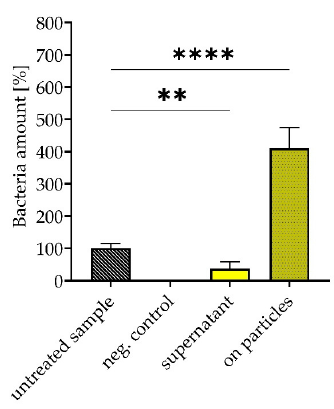
Figure 9. Removal and enrichment of S. aureus from platelet concentrate using 300 µg Fe/mL SPION- APTES-PepA. Samples were spiked with bacteria at a concentration of 10 3 CFU/mL. The unspiked platelet concentrate served as negative control. Experiments were performed in triplicates. The results shown represent the mean values with standard deviations of three independent donors. Statistical testing was performed using a two-way ANOVA test with post Dunn’s test; ** p ≤ 0.01; **** p < 0.0001. p values above 0.05 were considered non-significant (ns).